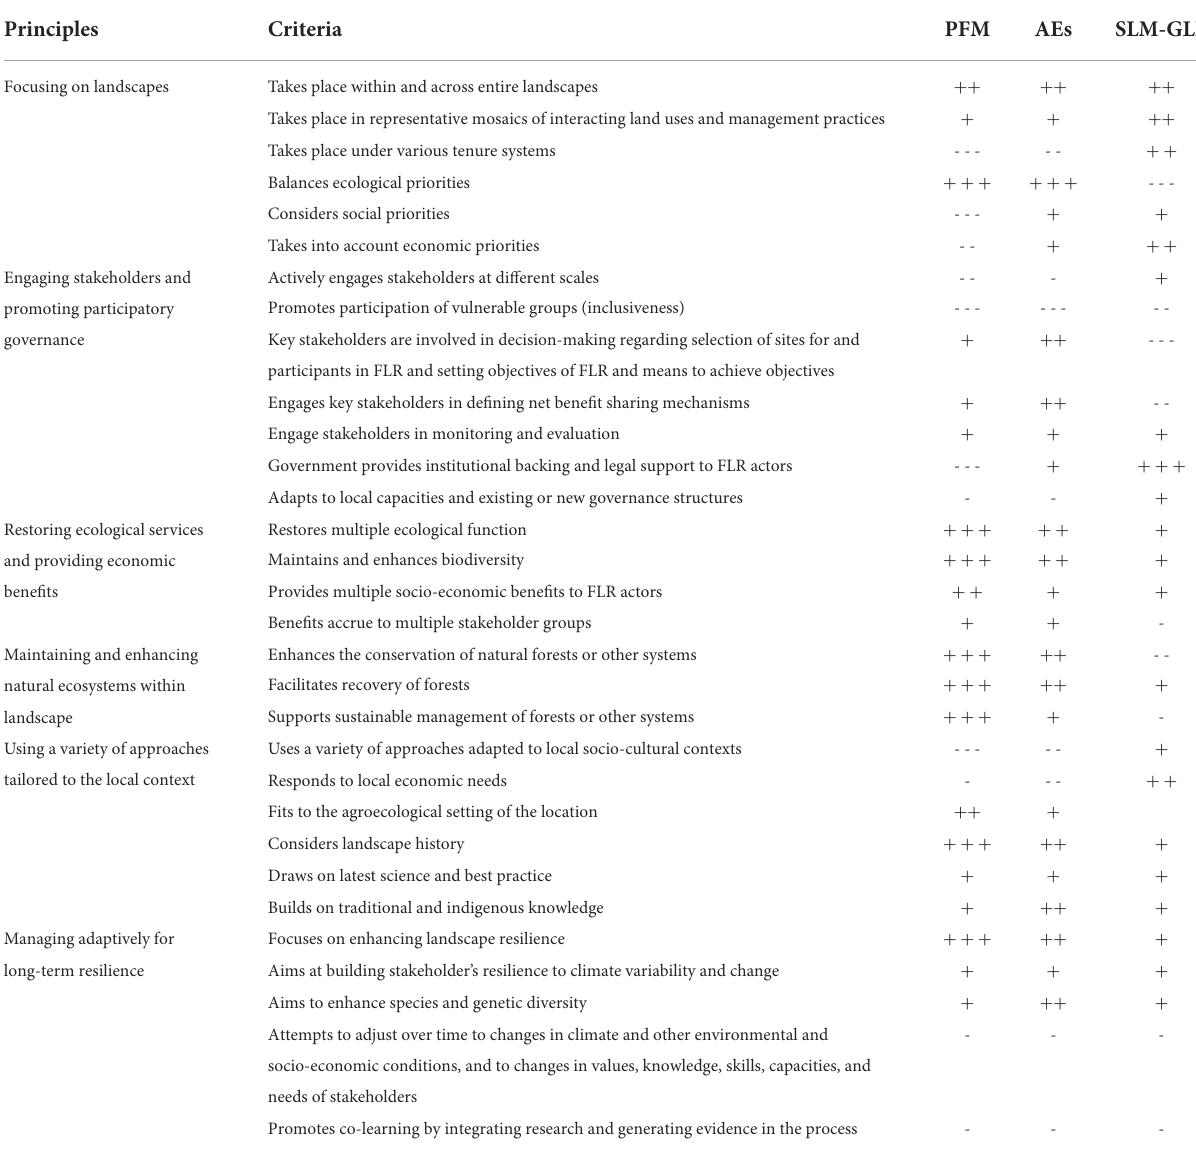
TABLE 1 Assessment of major state-led FLR initiatives against FLR